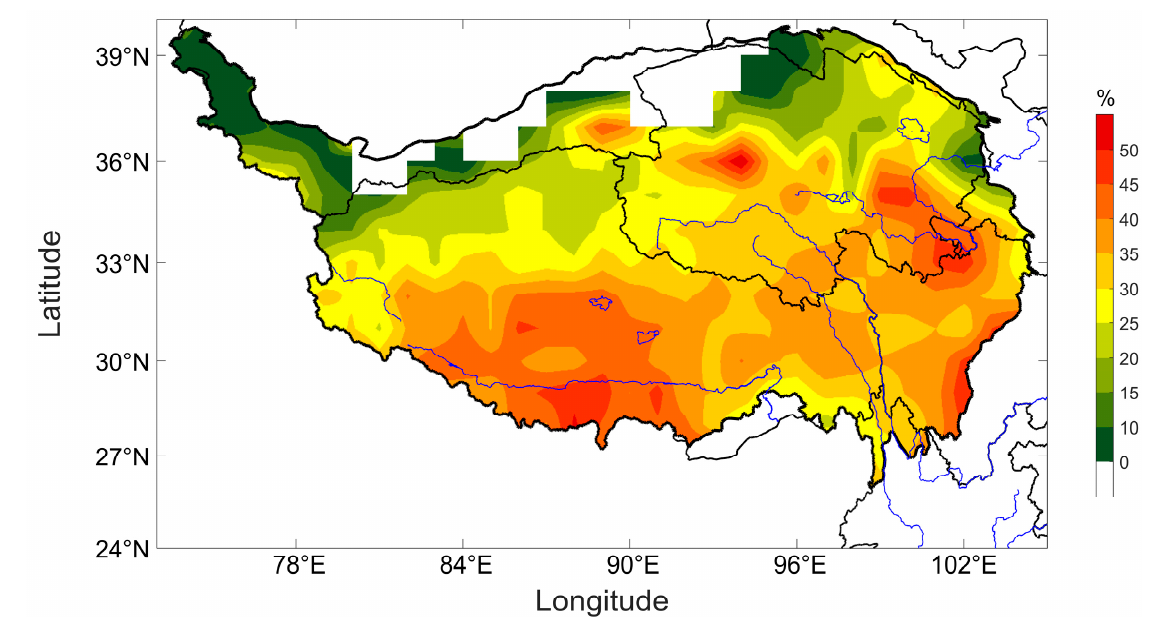
Figure 7. Spatial distribution of the proportion of thunderstorms containing SSCs during the warm season (from May to September), with the statistical grid size being 1° × 1°.